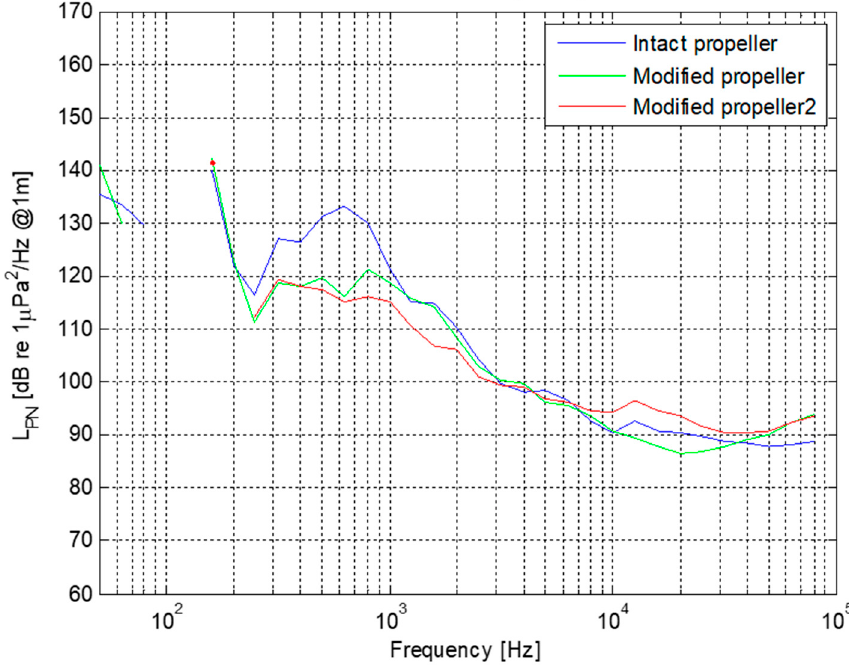
Figure 18. Comparison between Intact, Modified Propeller and Modified Propeller-2 net noise levels at 1 m (one third octave band), condition V2, hydrophone H3.